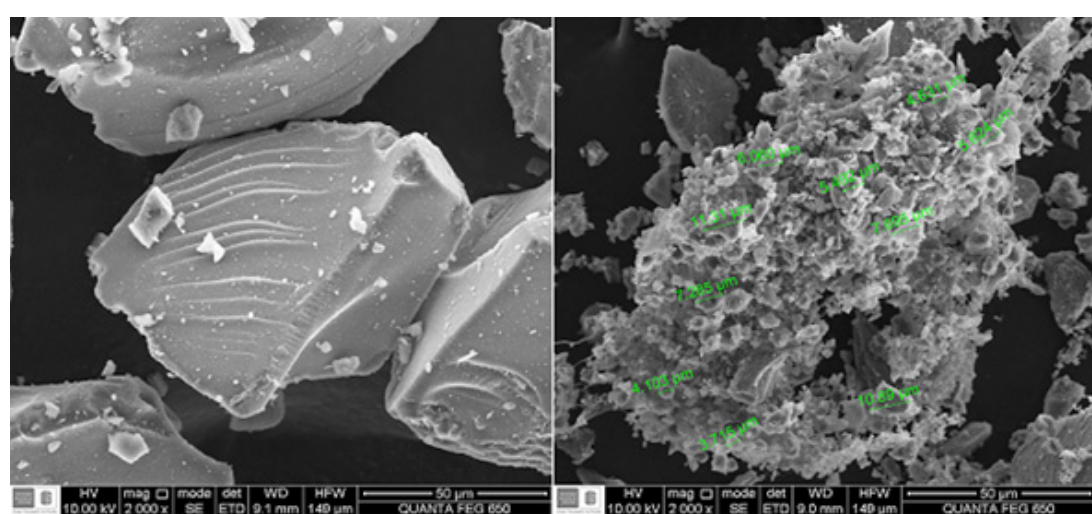
Figure 7. SEM images: on the left pure SiO